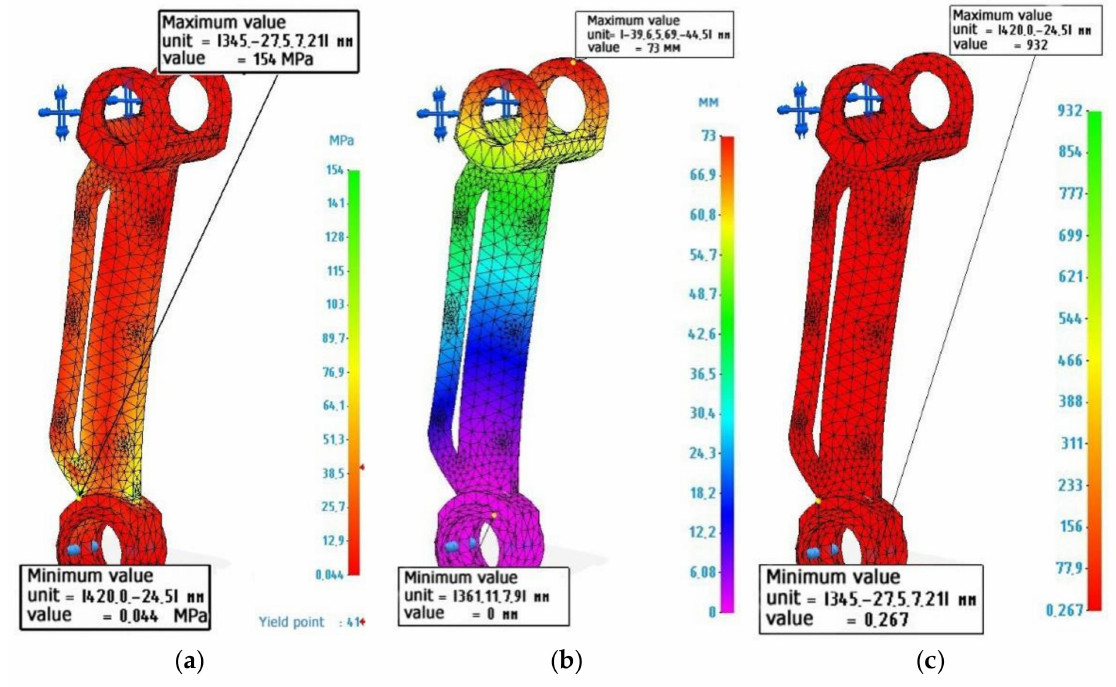
Figure 4. Finite element calculation of an exoskeleton lever made of Metal polymer “Ferro-chromium”: ( a ) Von Mises stress diagram, maximum value 154 MPa; ( b ) Strain diagram, maximum value 19.8 mm: ( c ) Safety factor diagram, minimum value 0.426.